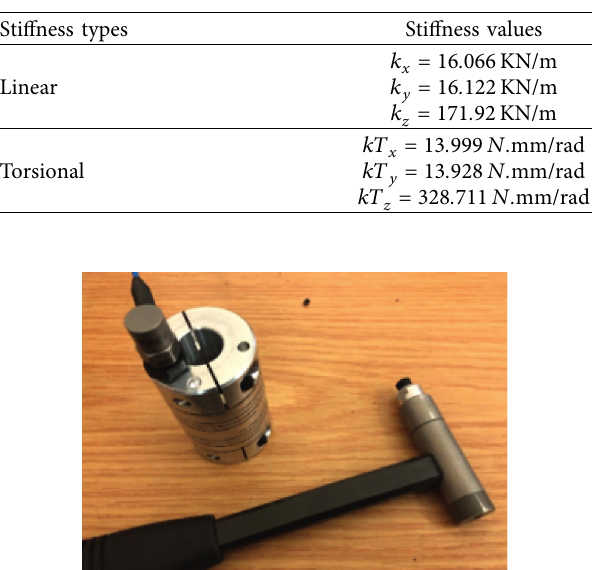
Table 2: Linear and torsional stiffness values of the coupling obtained by FE simulation.